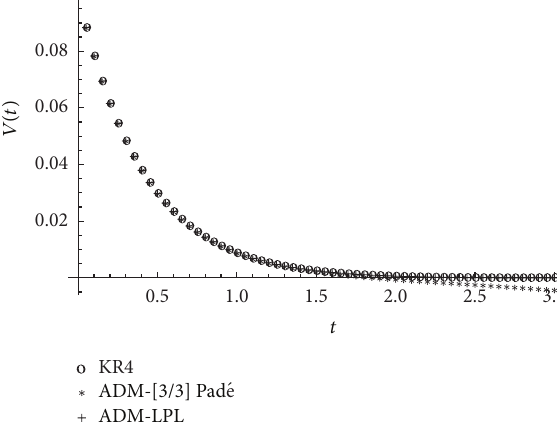
Figure 6: Curves of KR4 and ADM-[3/3] and ADM-[4/4] Pad´e approximations for 𝑉(𝑡) .